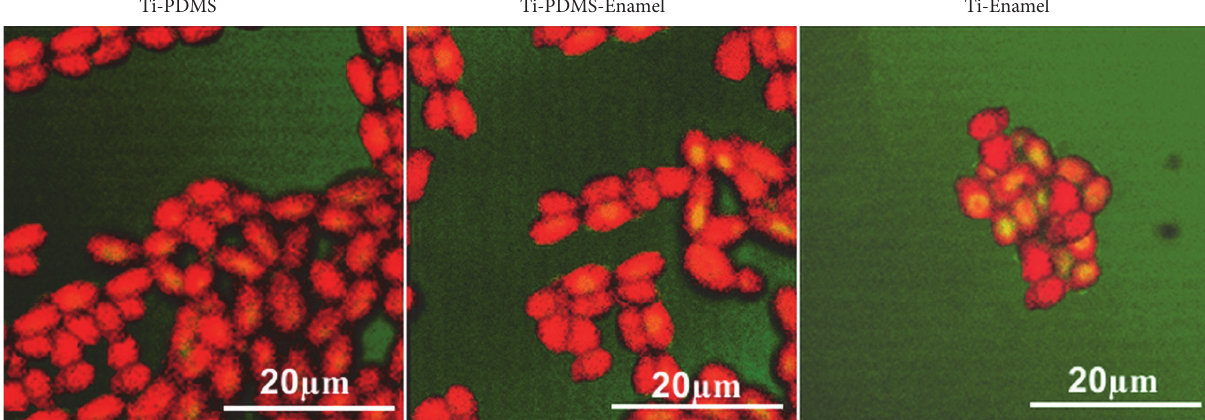
Figure 9: CLSM examination for viable C. albicans biofilm cells stained with ethidium bromide developed on the Ti-Enamel, Ti-PDMS- Enamel, and Ti-PDMS layers.